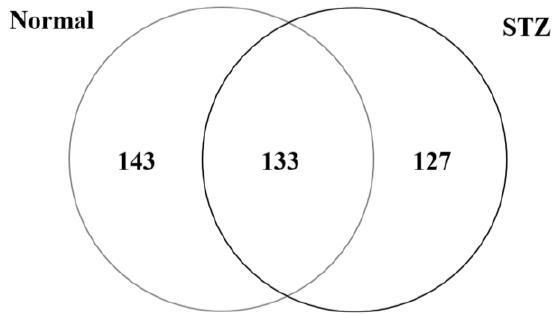
Figure 1. A Venn map of proteins identified from the cornea of normal and streptozotocin (STZ)-induced diabetic rats. We identified 276 proteins in the cornea of normal rats (Normal) and 260 proteins in cornea of STZ-induced diabetic rats (STZ).